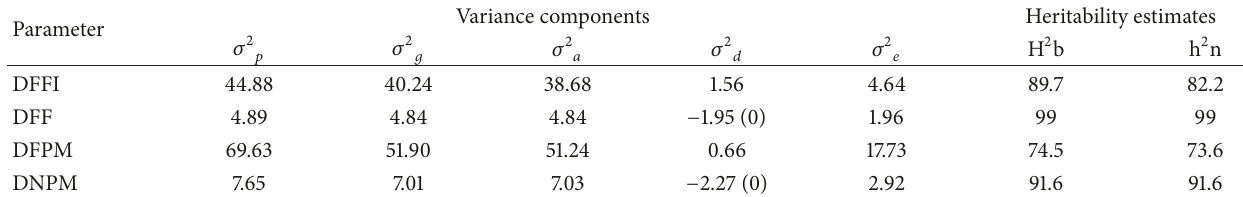
Table 2: Estimates of heritability based on variances of DFFI, DFF, DFPM, and DNPM. Parameter